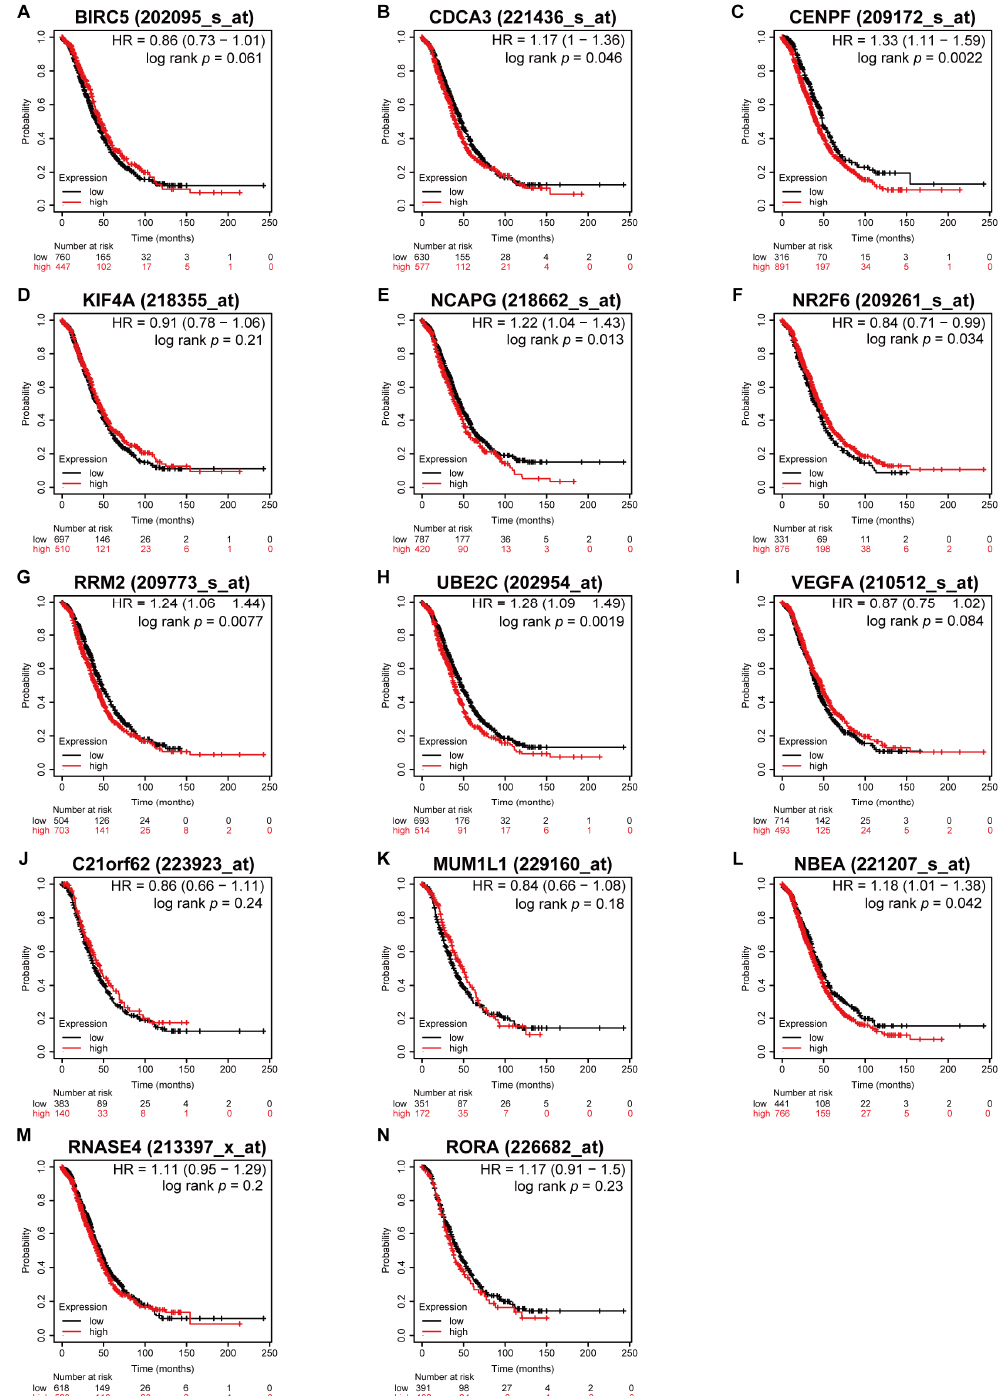
Figure 6. Survival analyses of the dysregulated genes in all stages of serous ovarian cancer. Kaplan–Meier plots of overall survival in subjects with higher versus lower expression. ( A ) BIRC5 , ( B ) CDCA3 , ( C ) CENPF , ( D ) KIF4A , ( E ) NCAPG , ( F ) NR2F6 , ( G ) RRM2 , ( H ) UBE2C , ( I ) VEGFA , ( J ) C21orf62 , ( K ) MUM1L1 , ( L ) NBEA , ( M ) RNASE4 , and ( N ) RORA mRNA